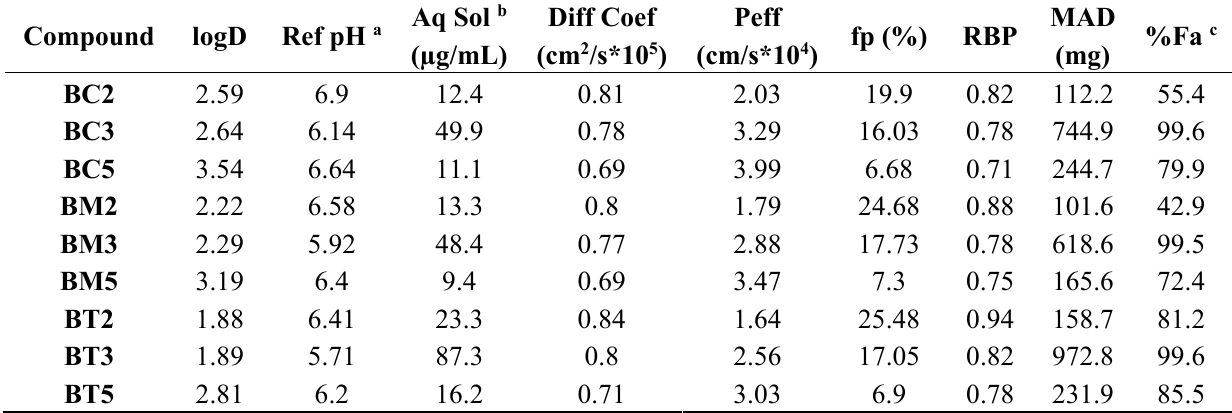
Table 4. The main biopharmaceutical descriptors of the tested compounds, as simulated by GastroPlus TM